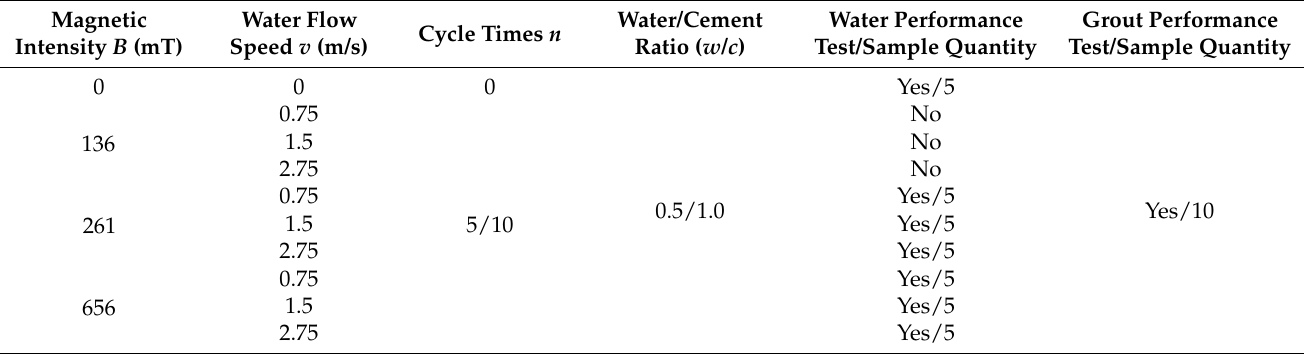
Table 3. Design of experimental